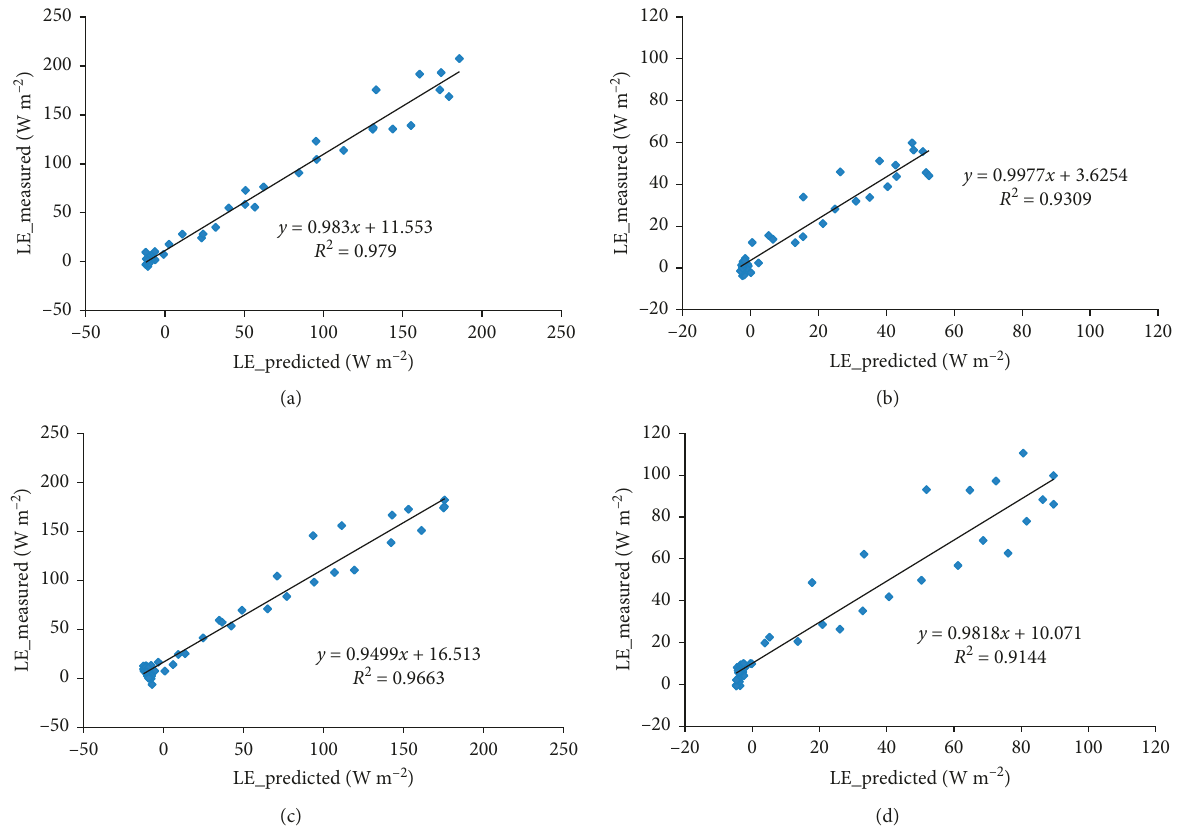
Figure 4: Comparisons between measured and predicted LE (W (d) cool 2006.